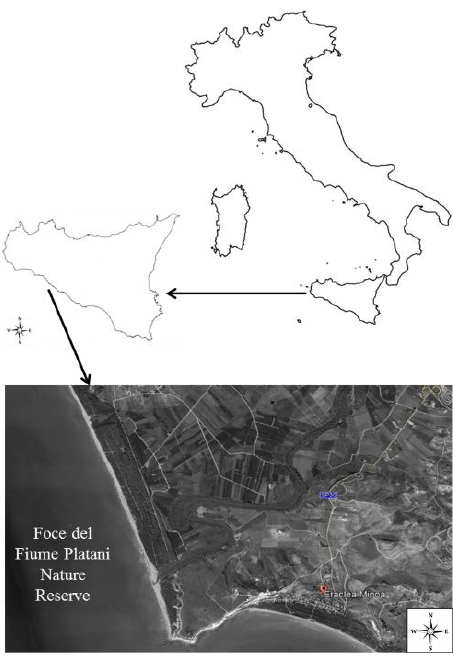
Figure 1. The geographic location of the “Foce del Fiume Platani” Nature Reserve on the southwestern coast of Sicily.